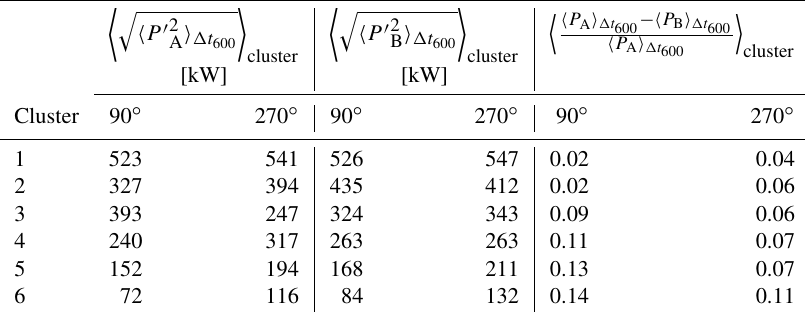
Table C1. Averaged wind turbine statistics computed for wind direction intervals around 90 and 270 ◦ and k = 6, with A as the upstream wind turbine and B as the downstream wind turbine. over a 600s interval (cid:49)t 600 (analogue for wind turbine B for the same 600s intervals, respectively). (cid:104) P A (cid:105) (cid:49)t power of wind turbines A and B over the same 600s intervals. (cid:104) ... (cid:105) cluster denotes the average of the statistics over all available time intervals of the wind turbine pairs. Note that here 90 and 270 ◦ again refer to 20 ◦ wind direction intervals from 80 to 100 ◦ and from 260 to 280 ◦